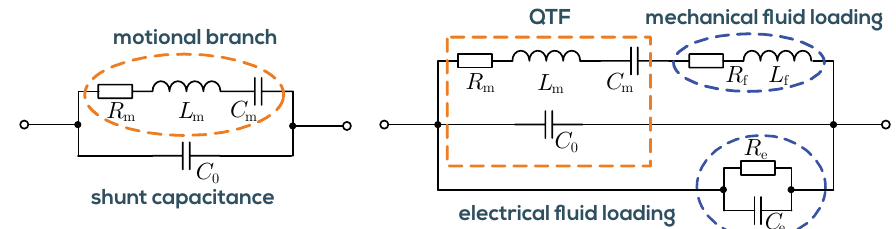
Figure 3. Left : Butterworth–Van Dyke equivalent circuit model for the unloaded quartz crystal tuning fork (QTF). The electro-mechanical resonance is modeled by the series resonant circuit termed motional branch with shunt capacitance C 0 in parallel accounting for the capacitance formed by electrodes and quartz material. Right : Liquid mass-loading and viscous drag are modeled by L f and R f . The conductivity and permittivity of the liquid in contact with the electrodes are modeled by R e and C e .